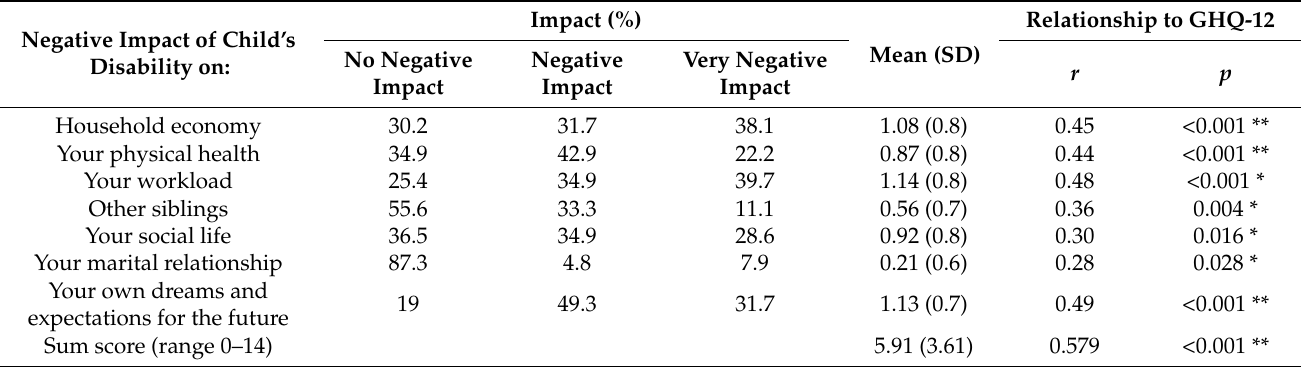
Table 3. Caregiver impact score.